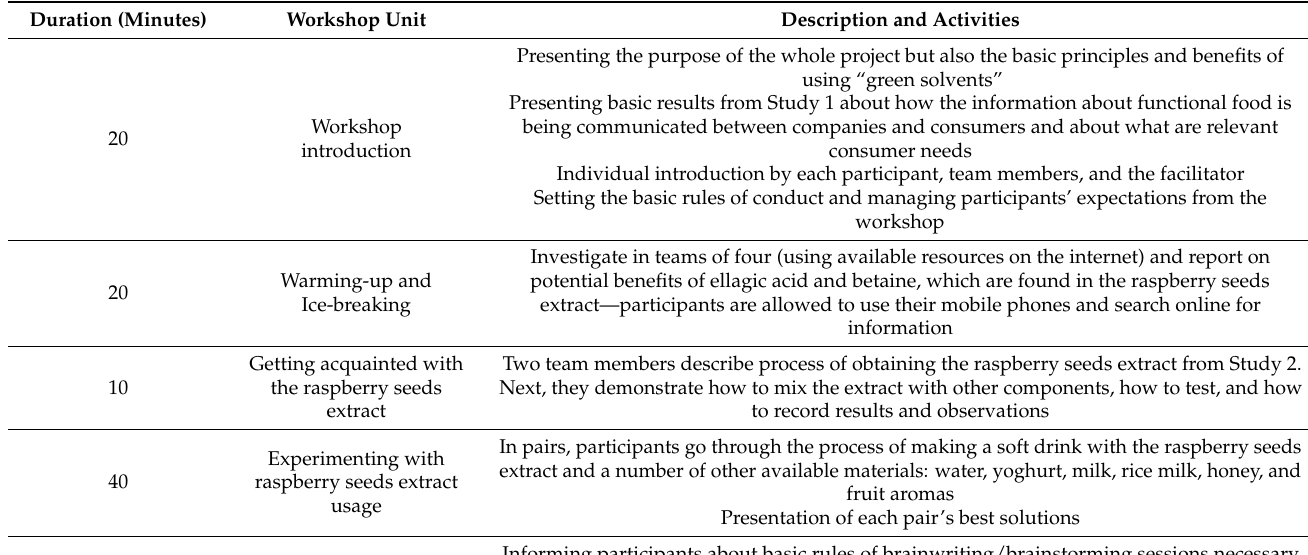
Table A1. Workshop structure and